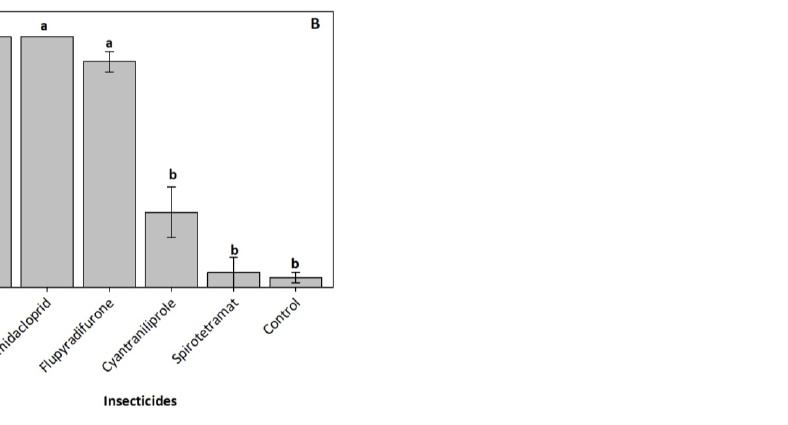
Figure 1. Mortality percentage (± standard error) of the stingless bees Nannotrigona perilampoides ( A ) and Frieseomelitta nigra ( B ), orally exposed for 24 h to the insecticides at field recommended doses, dinotefuran (600 mg a.i. L −1 ), imidacloprid (700 mg a.i. L −1 ), flupyradifurone (680 mg a.i. L −1 ), spirotetramat (300 mg a.i. L −1 ), and cyantraniliprole (200 mg a.i. L −1 ). Bars with different letters are statically different (Tukey test, n = 5, p < 0.05).